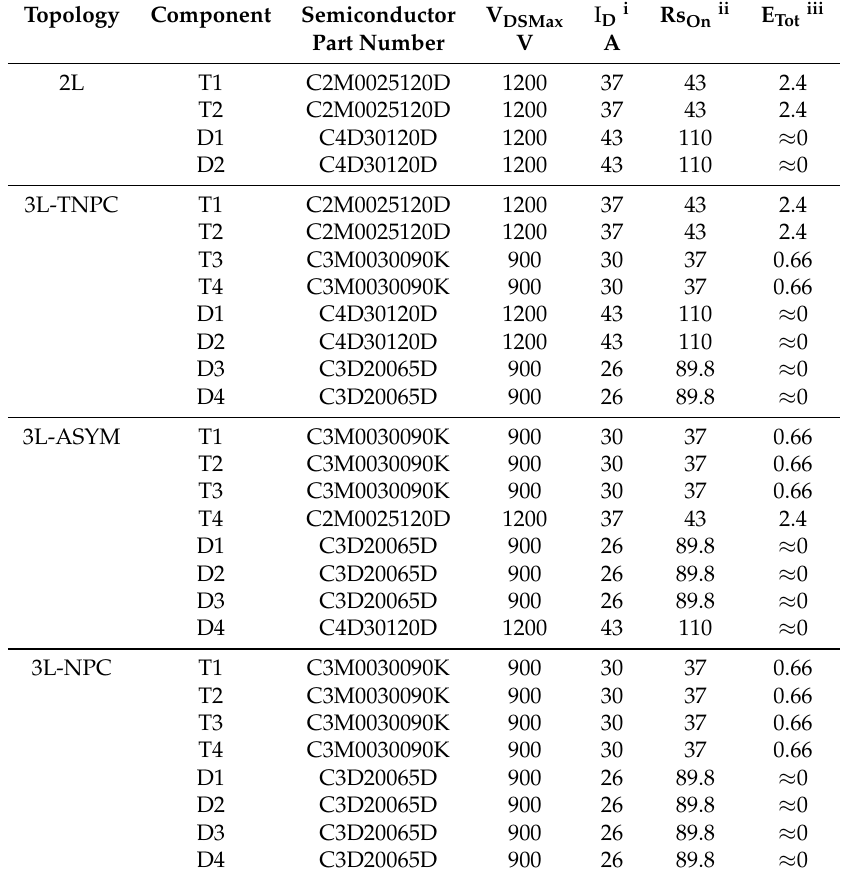
Table 3. Parameters of the power semiconductors used for the comparative evaluation. Topology